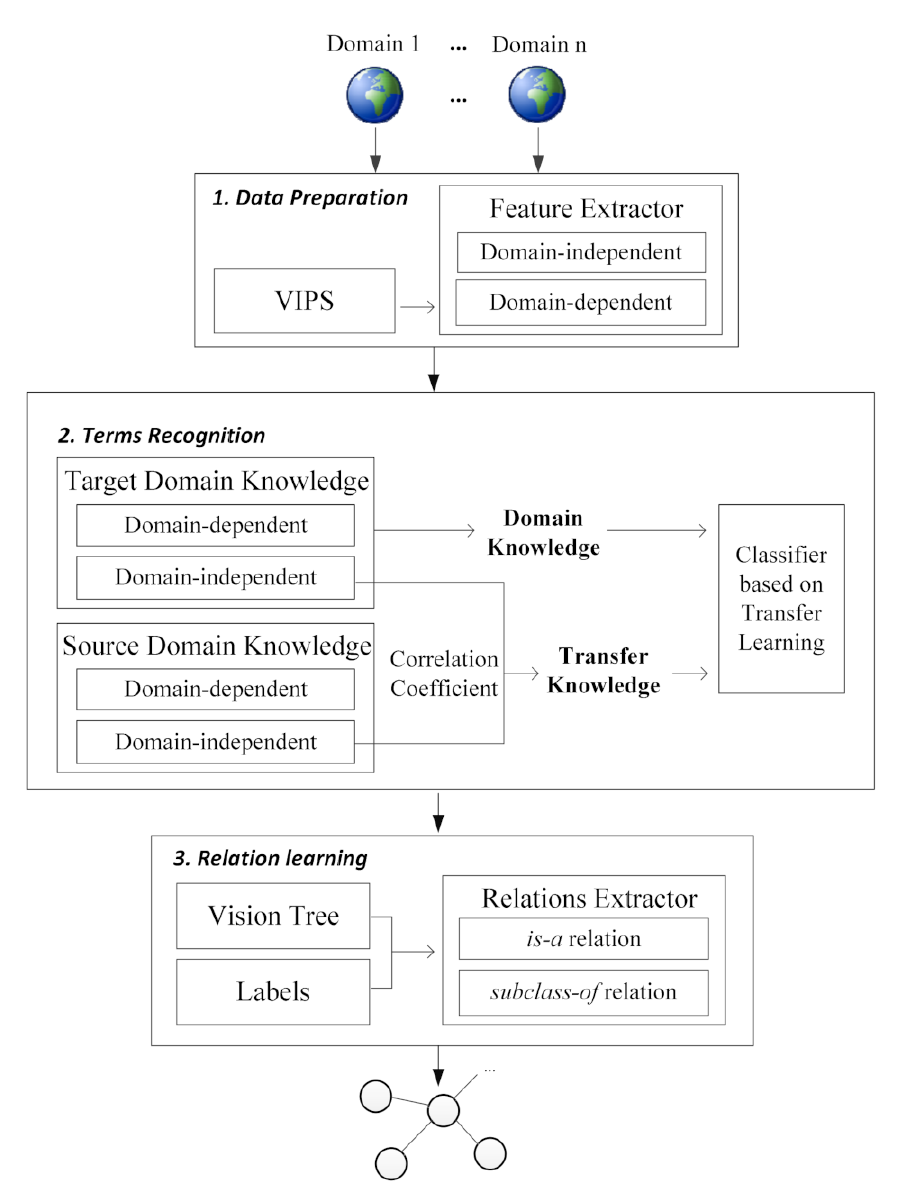
Figure 1. Overview of Our